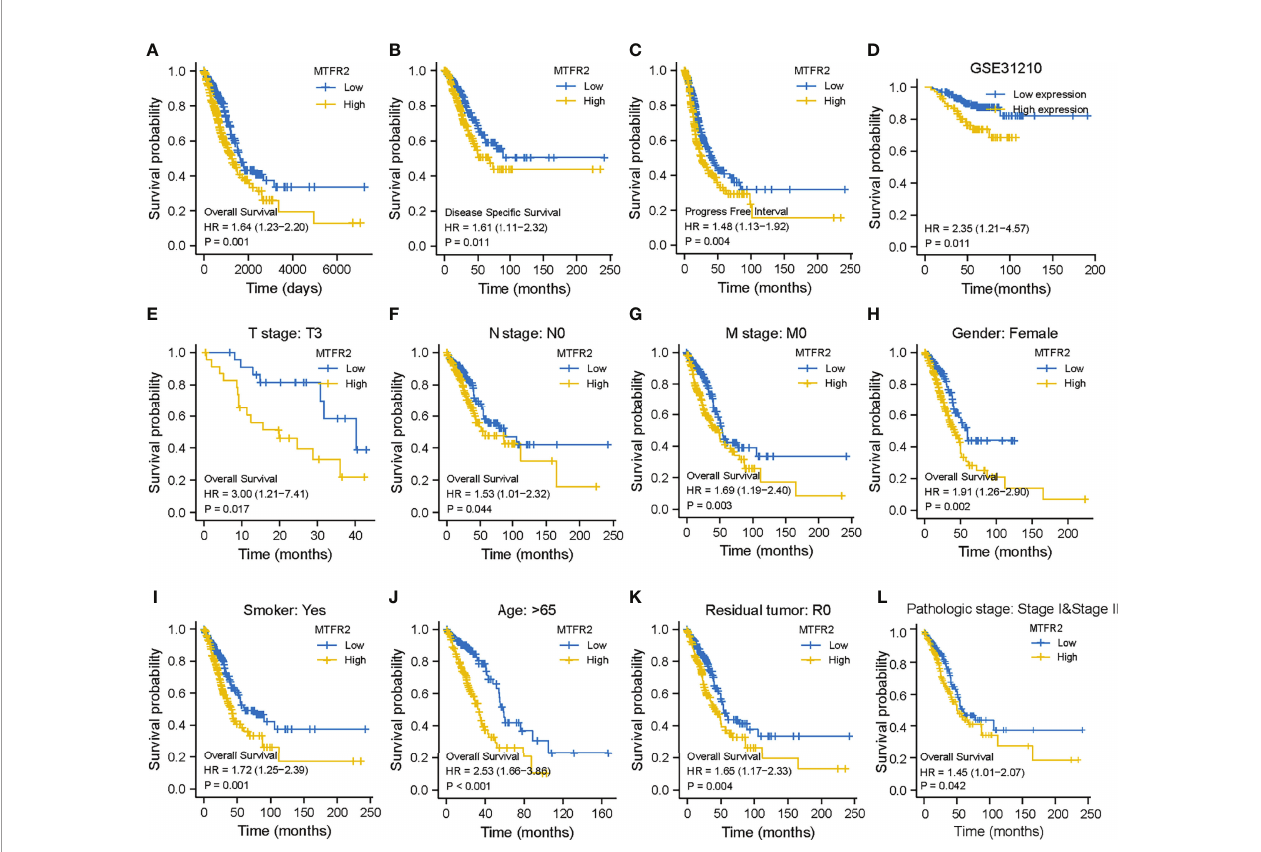
FIGURE 3 | MTFR2 expression was correlated with survival status in LUAD patients. Higher MTFR2 expression was associated with poorer overall survival ( P = 0.001) (A) , disease-speci fi c survival ( P = 0.011) (B) , progression-free interval ( P = 0.004) (C) , overall survival ( P = 0.011) (D) , and overall survival in T3 stage ( P = 0.017) (E) , N0 stage ( P = 0.044) (F) , M0 stage ( P = 0.003) (G) , female gender ( P = 0.002) (H) , smoke ( P = 0.001) (I) , >65 years ( P < 0.001) (J) , residual tumor R0 ( P = 0.004) (K) , and pathological stage ( P = 0.0042) (L)